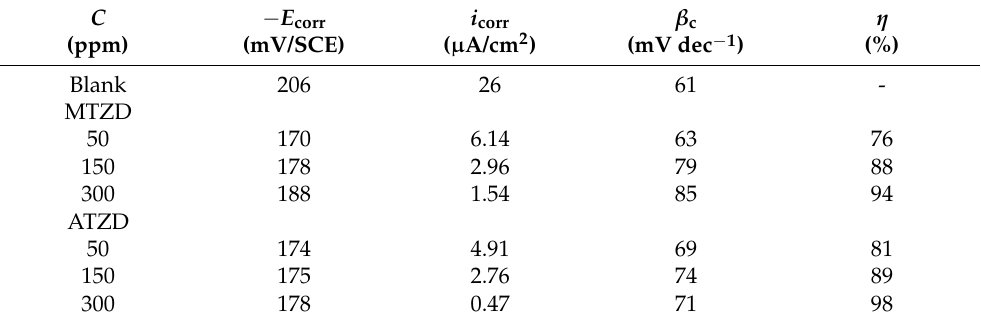
Table 3. PDP parameters for copper in 3.5 wt.% NaCl solution and in presence of inhibitors at 298